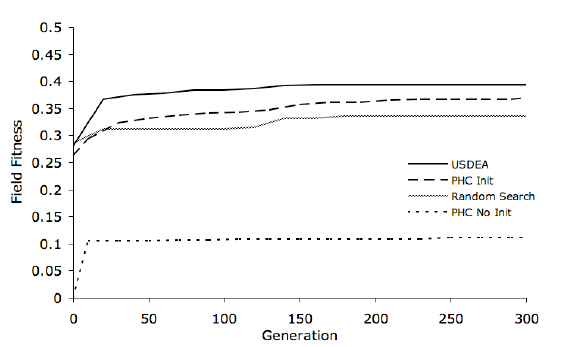
Fig.5. Benchmarking for a Mesh Field with an MCSS of